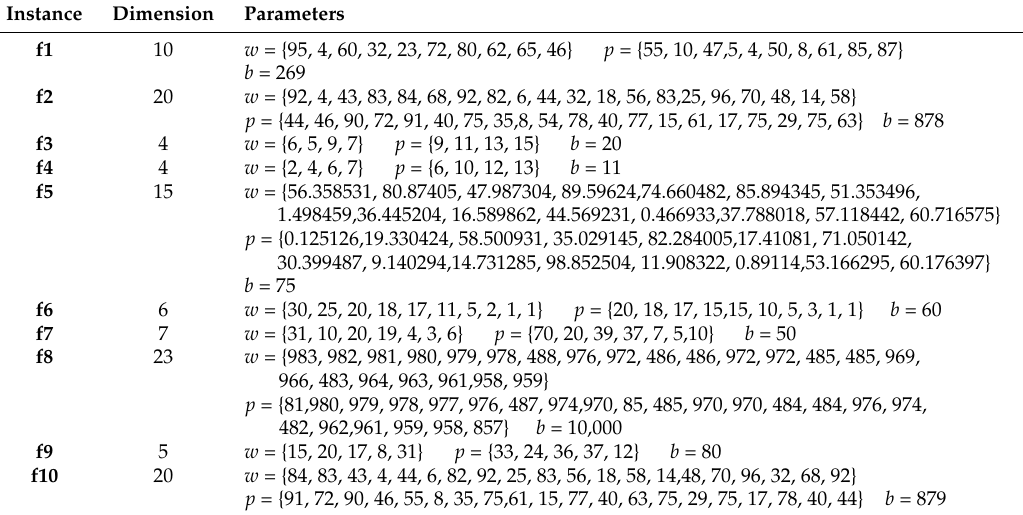
Table 2. 0/1 Knapsack Problem instances.